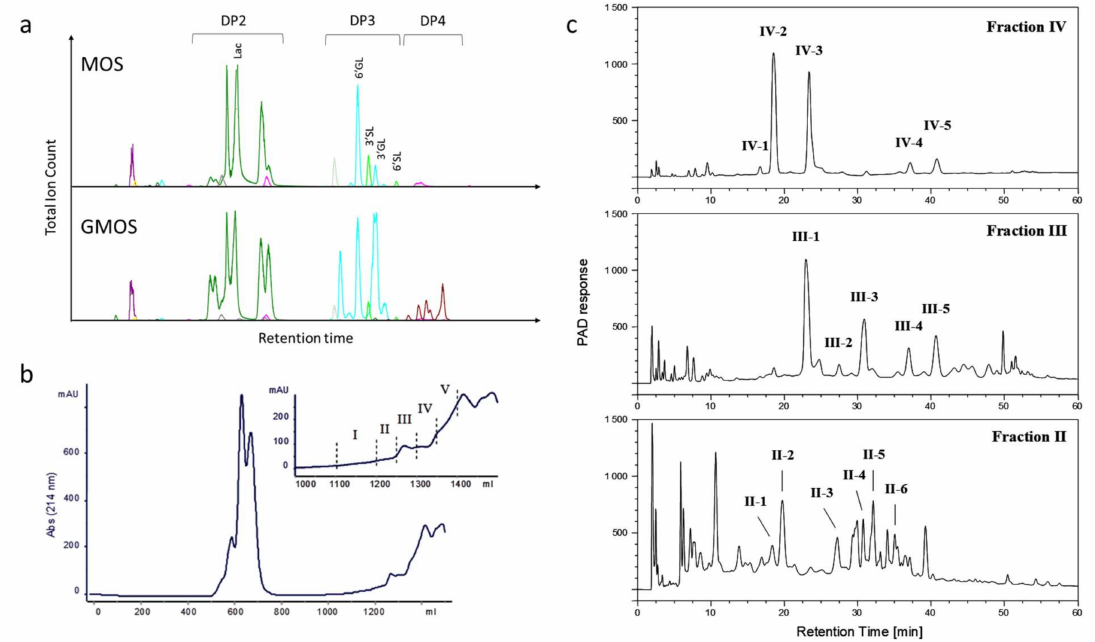
Figure1. ( a )IllustrationofLC-MStracesofMOSandGMOS;( b )Gel-filtrationchromatographyofGMOS indicating isolated fractions. The eluted carbohydrates were pooled into five fractions for subsequent analyses as shown in the inset; ( c ) HPAE chromatography of gel-filtration chromatography fractions II–IV. Fractions IV and III were run with gradient 1, and fraction II with gradient 2. The indicated fractions were analyzed as described in the text. Lac, lactose; 3 (cid:48) GL, 3 (cid:48) Galactosyllactose; 6 (cid:48) GL, 6 (cid:48) Galactosyllactose; 3 (cid:48) SL, 3 (cid:48) Sialyllactose; 6 (cid:48) SL, 6 (cid:48) Sialylactose; DP, degree of